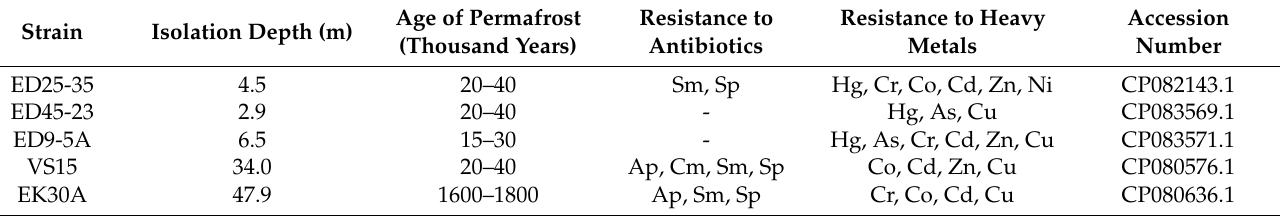
Table 1. Analyzed permafrost strains of A. lwoffii